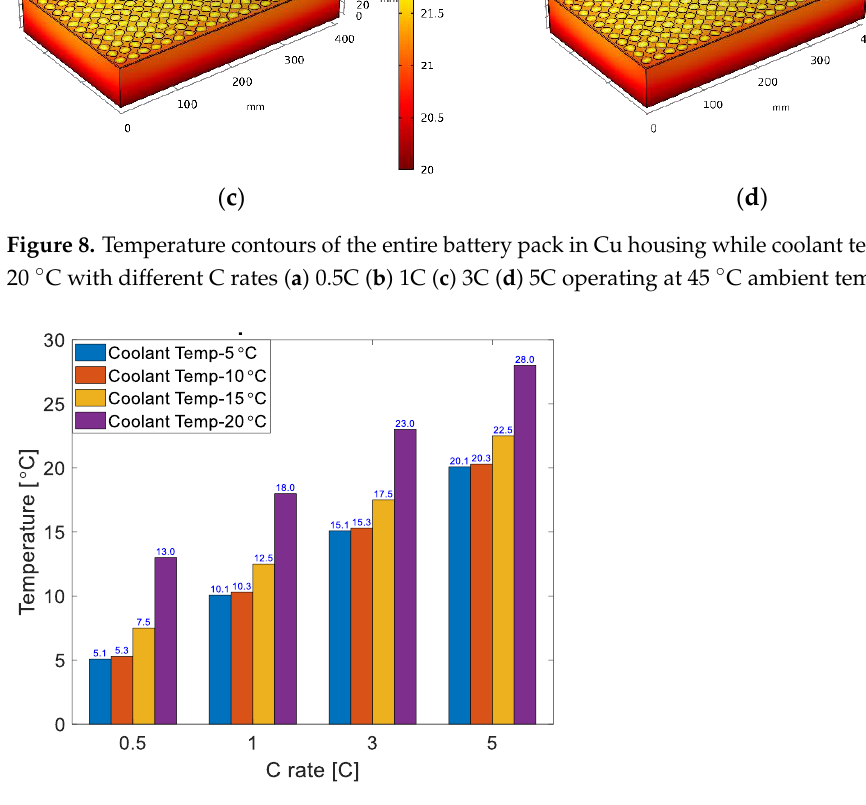
Figure 9. Maximum temperature elevations of battery pack fitted with Cu battery housing under different coolant temperatures at varied C rates operating at 45 °C ambient temperature.